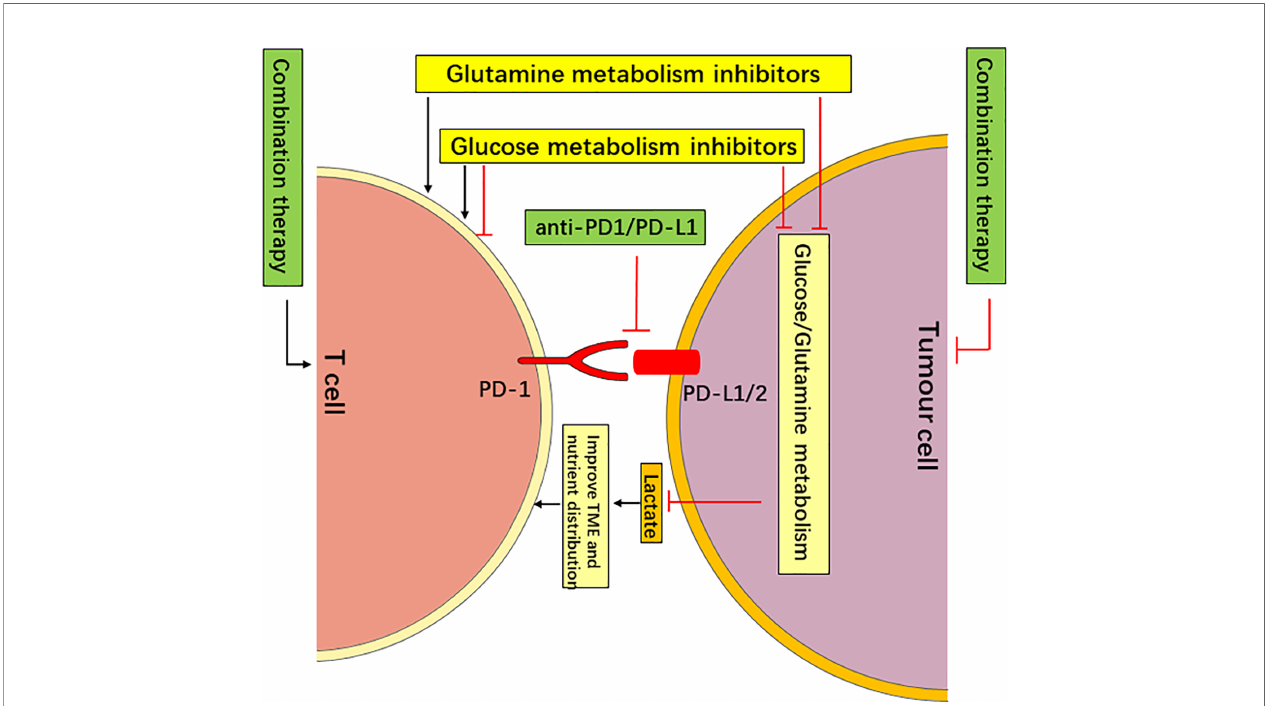
FIGURE 3 | Targeting Metabolism in Combination with PD-1/PD-L1 Checkpoint Blockade Immunotherapy May Have a Synergistic Anticancer effect. The targeting of glucose or glutamine metabolism has an antitumor effect by starving tumors, and it improves the nutrient distribution and acidic TME, which is more conducive to the function of T cells. The targeting of glutamine metabolism may improve the function of T cells via metabolic reprogramming (such as DON and V-9302). However, the targeting of glucose metabolism may enhance or inhibit the function of different types of T cells (such as 2-DG). Therefore, the targeting of glucose or glutamine metabolism in combination with PD-1/PD-L1 checkpoint blockade immunotherapy may have a synergistic anti-cancer effect.